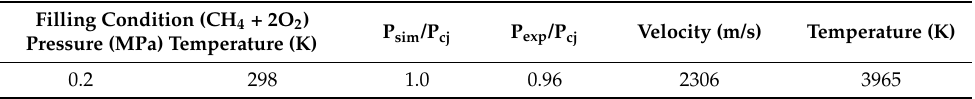
Table 4. Comparison with theoretical value of detonation wave from simulation and